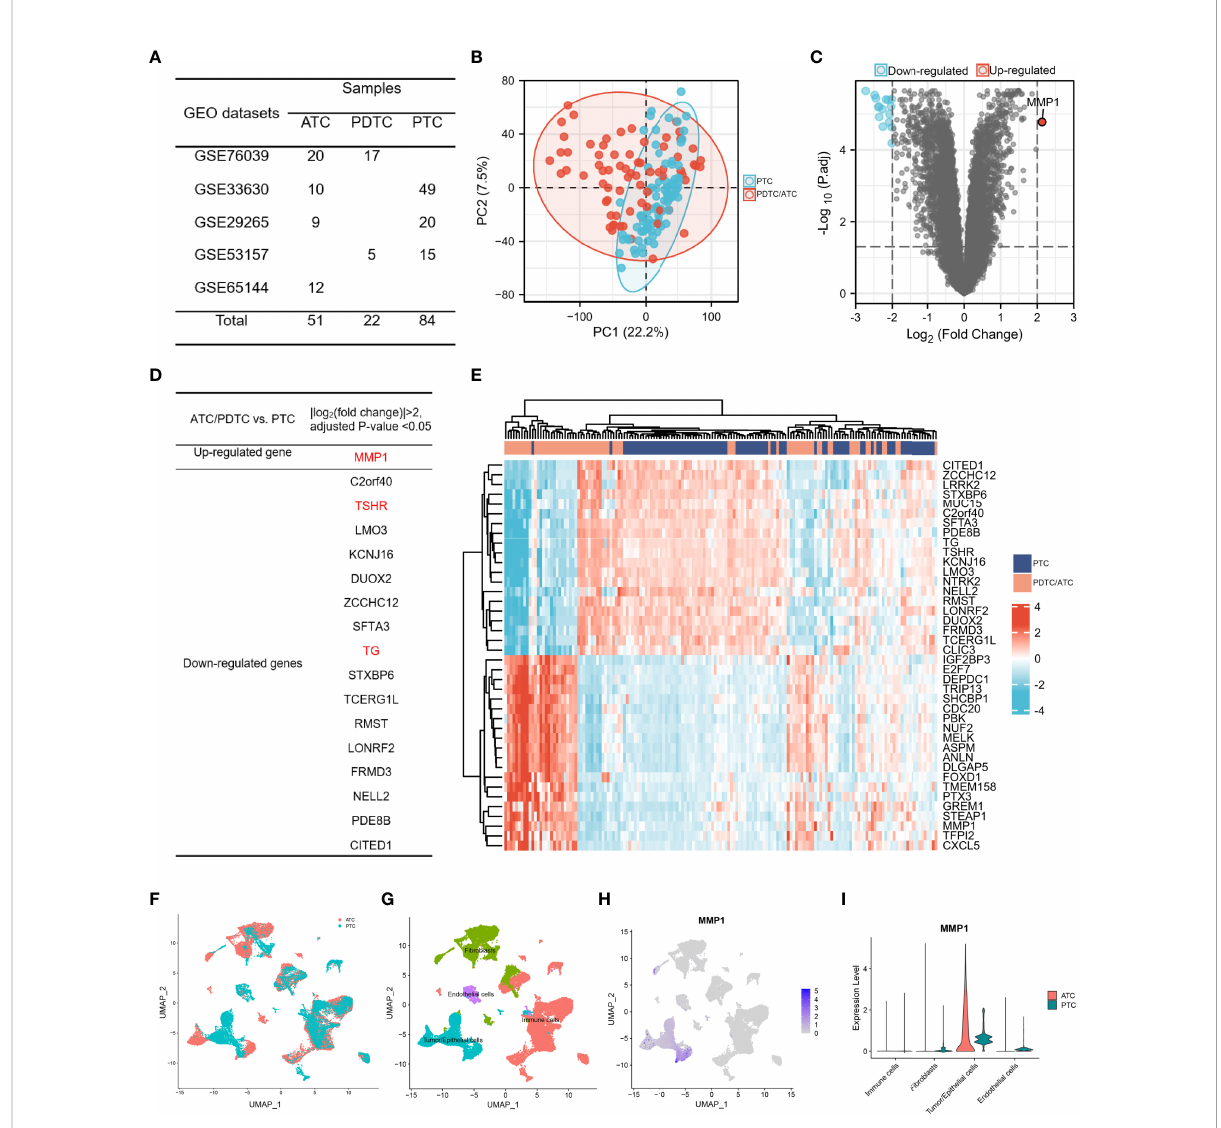
FIGURE 2 The identi fi cation of MMP1. (A) TC samples from the GEO database included in this study; (B) PCA map between PDTC/ATC and PTC. The difference between PTC and PDTC/ATC samples was not very large. (C) Volcano plots exhibited the DEGs between PDTC/ATC and PTC. (D) List of DEGs between PDTC/ATC and PTC. (E) . Heat map of MMP1 and another top 40 DEGs between PDTC/ATC and PTC. (F) Single-cell sequencing data in fi ve ATC and six PTC patients. (G) Four basic types of cells in single cell sequencing data: tumor/epithelial cells, immune cells, endothelial cells and fi broblasts. (H) MMP1 expression in different cells. (I) Relative quanti fi cation of MMP1 expression level. GEO, the Gene Expression Omnibus; PDTC, poorly differentiated thyroid cancer; ATC, anaplastic thyroid cancer; PTC, papillary thyroid cancer; DEG, differentially expressed